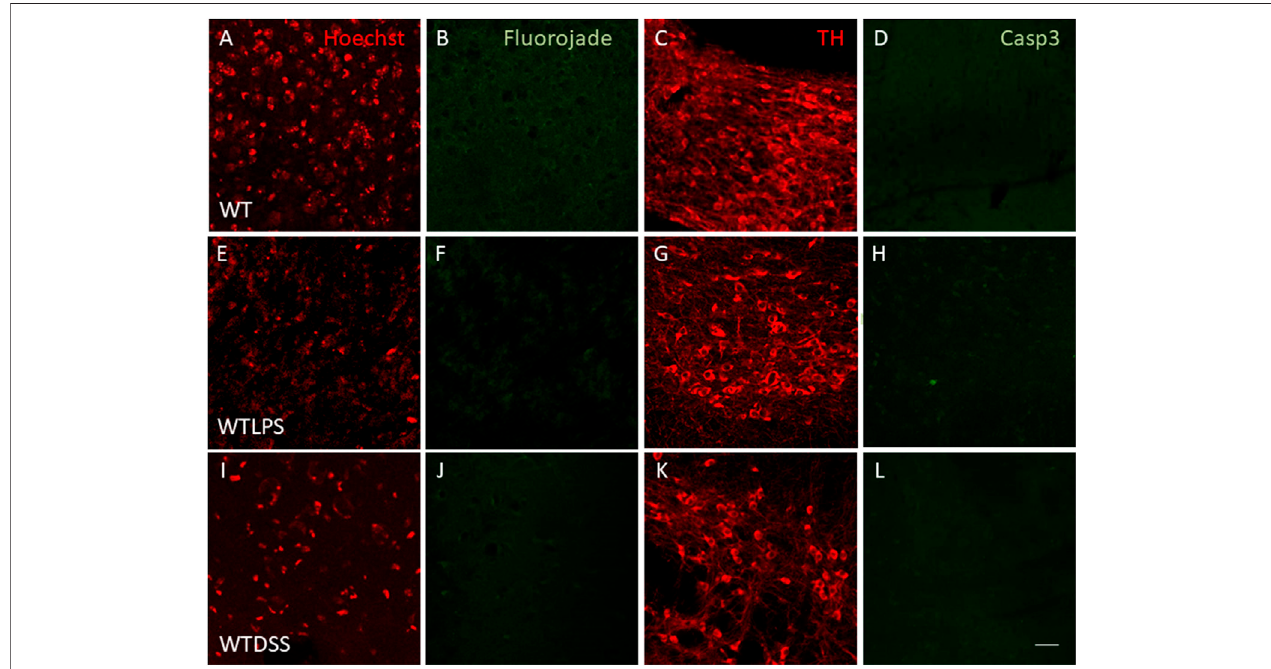
FIGURE 11 | Effect of the treatment with LPS or DSS in the degeneration of dopaminergic neurons. Representative images from sections of WT, WTLPS and WTDSS animals. After 5 days of LPS treatment no signs of neurodegeneration or apoptosis were found (E – H) compared to the control group (A – D) . After 10 days of treatment with DSS neither neuronal degeneration (J) nor signs of apoptosis (L) were found compared to the control group (A – D) . Scale bar: 150 μ m. Abbreviations: WT, wild type mice; WTLPS, WT animals treated with LPS; WTDSS, wild type mice treated with